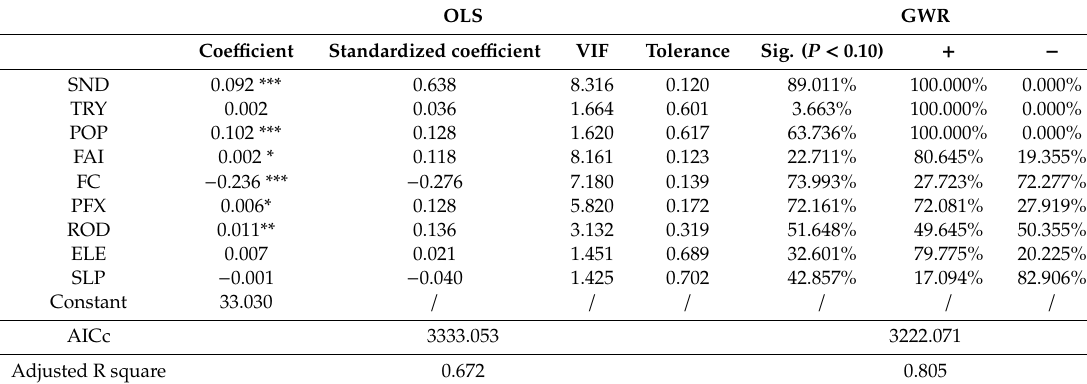
Table 3. Results of the OLS regression and GWR.